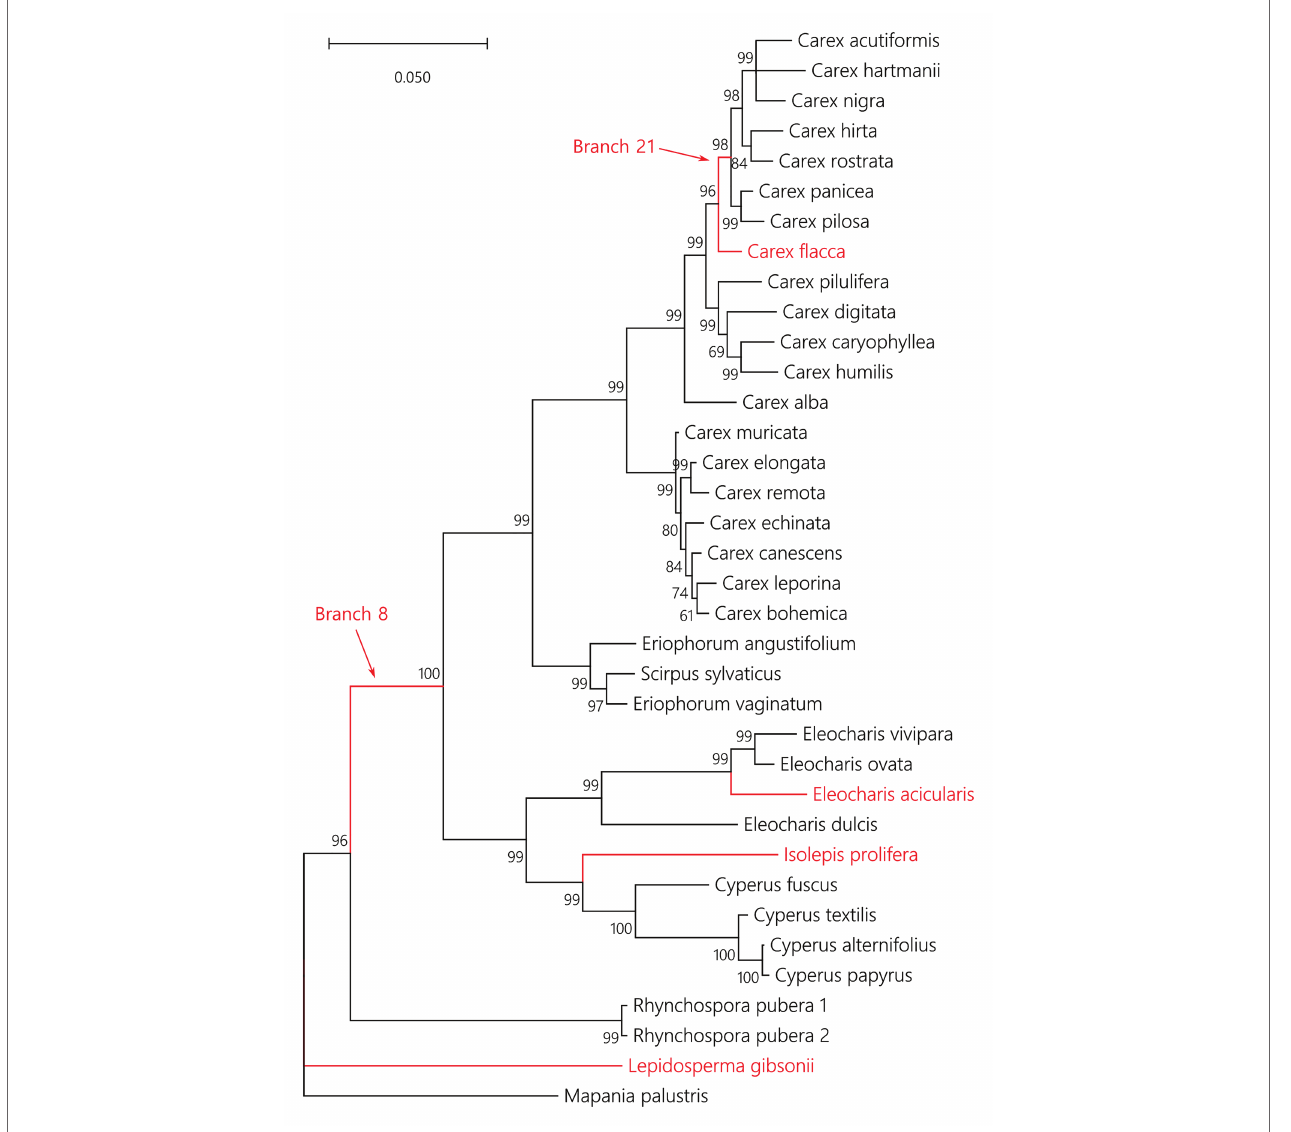
FIGURE 2 | Phylogenetic tree of analyzed CenH3 sequences with six branches under positive selection depicted in red. The numbers above or below branches are statistical supports in Bayesian posterior probabilities. The aBS-REL output containing the exact p values of positive selection tests for each branch is available in Supplementary Table S7